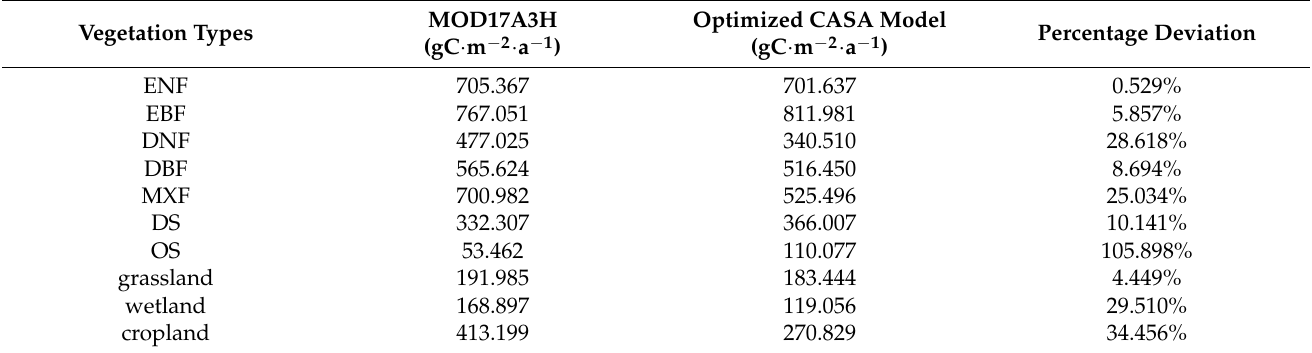
Table 3. Comparison of NPP mean values of different vegetation types based on MOD17A3H and optimized CASA model.